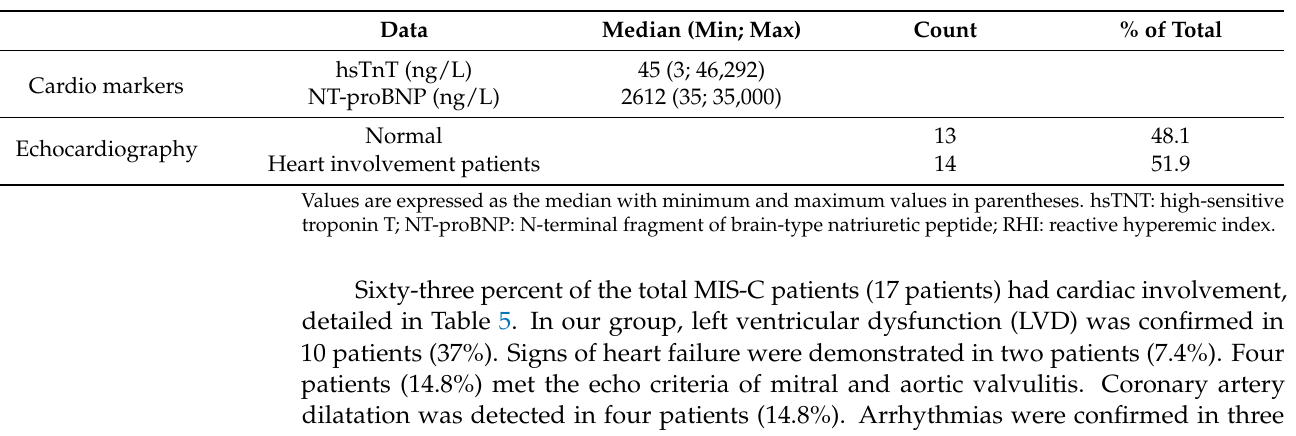
Table 5. MIS-C: heart involvements.